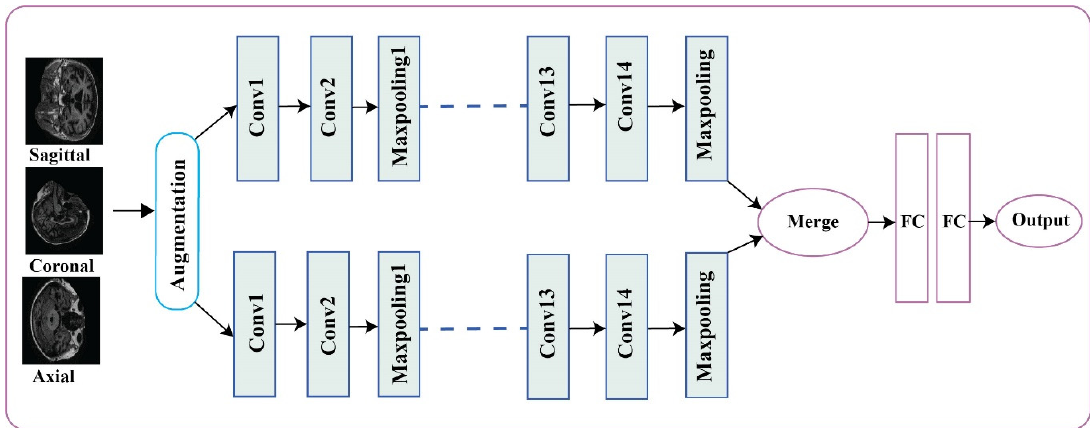
Figure 1. Proposed siamese convolutional neural network (SCNN) model for the Classification of Alzheimer’s Stages.